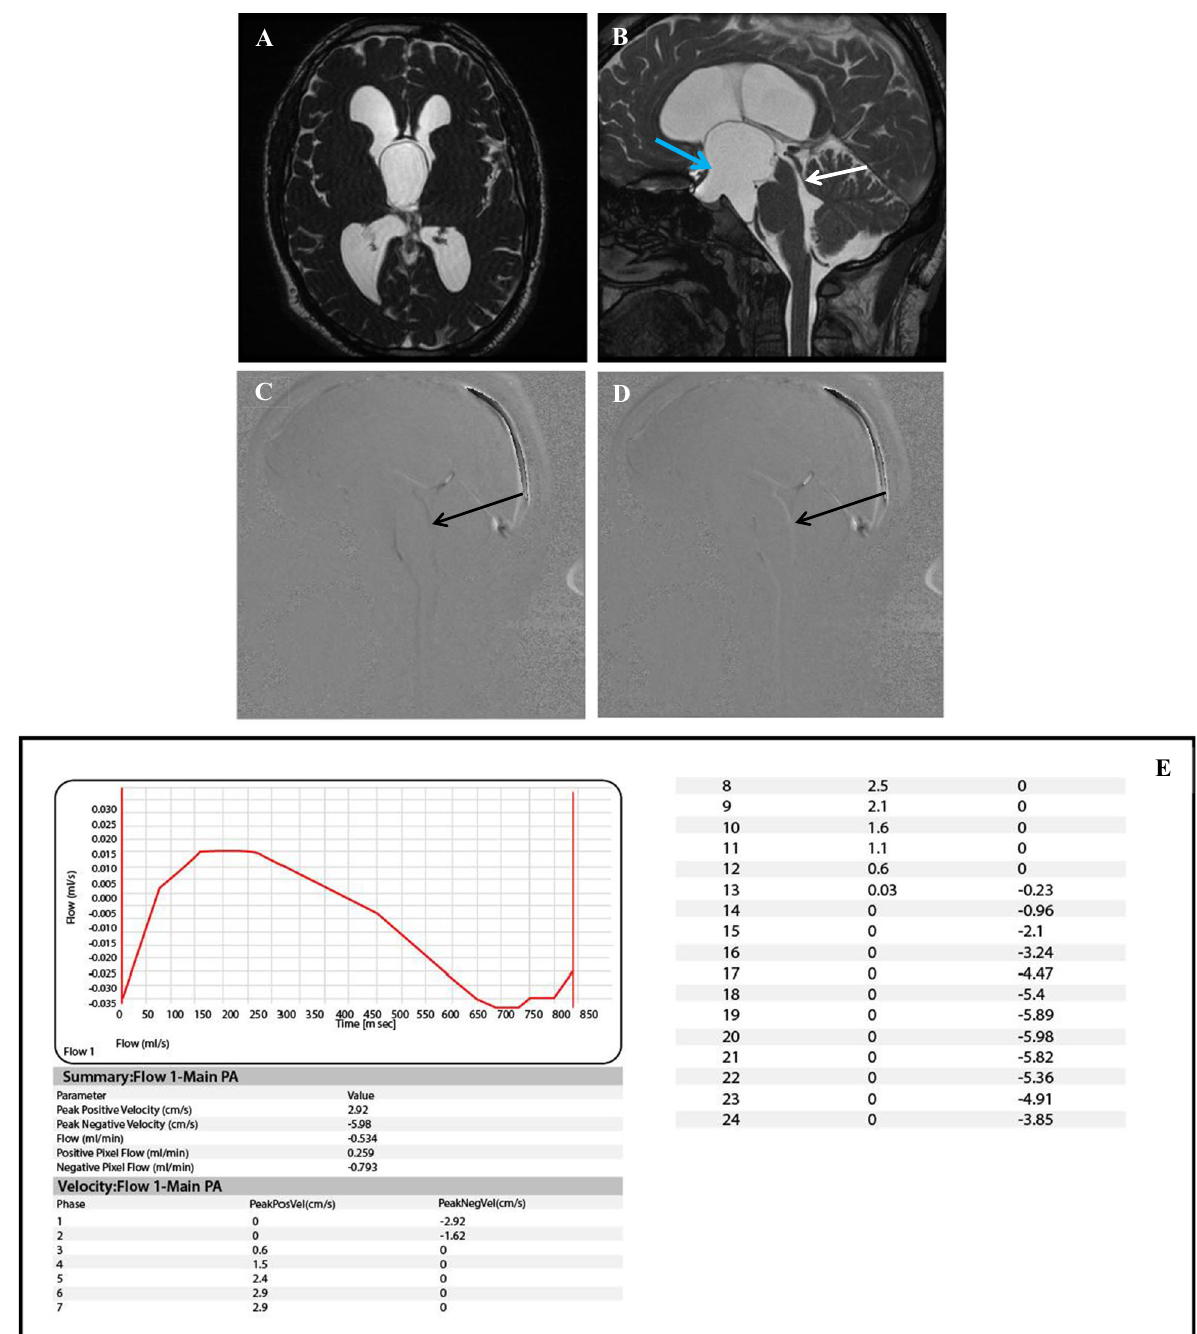
Fig. 4 A – E A 10‑year‑old male child with headache and blurred vision. A Axial FIESTA image shows mild dilation of supratentorial ventricular system, and cystic lesion at floor of third ventricle. B Sagittal T2 DIVER image reveals patent normal aqueduct with normal flow void (white arrow) and a suprasellar cystic lesion (blue arrow) reaching the floor of third ventricle and compressing it with no communication between the cyst and neighboring CSF spaces. C , D Sagittal phase‑contrast images reveal normal CSF flow through the aqueduct at systole ( C ) and diastole ( D ) (black arrows) with no jet flow between intra ventricular cyst lesion and neighboring CSF spaces, and E velocity time curve‑ and CSF flow curve‑associated table reveals CSF in both diastole (above the base line) and systole (below the base line) with PSV: 5.9 cm/s, PDV:2.92 cm/s, MV: 4.45 cm/s, MSF: 0.04 m/s and SV: 16.6 µl (normal dynamic CSF circulation with normal CSF velocities and stroke volume and normal flow through aqueduct of Sylvius obstructive hydrocephalus due to compression of the third ventricle by a suprasellar arachnoid cyst not communicating with CSF